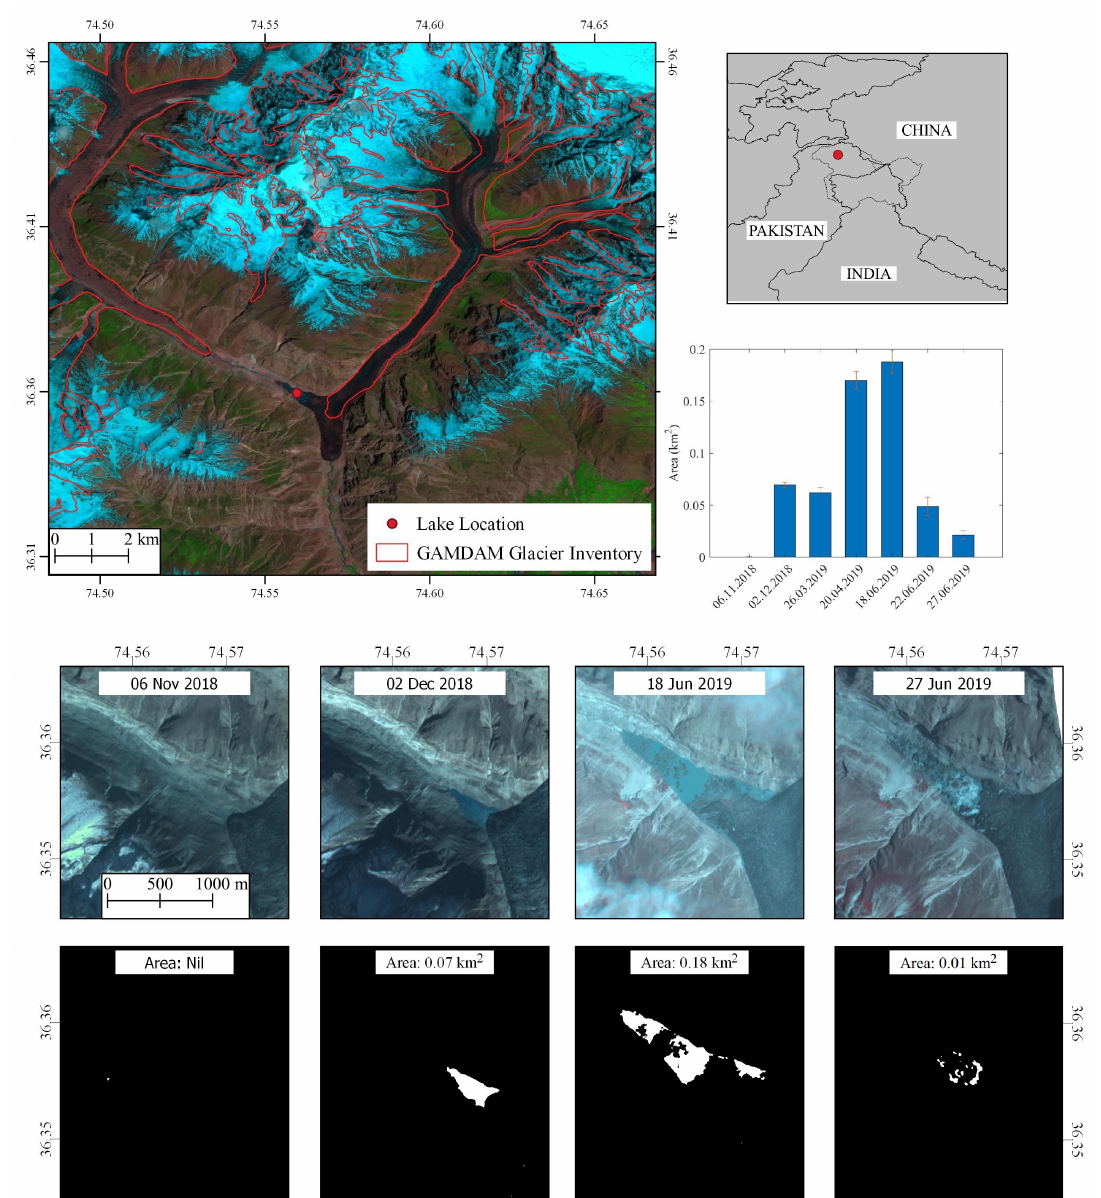
Figure 15. Top: The Shishper glacier shown on a Sentinel-2 FCC Bands: (11,8,4). The glacier boundaries from GAMDAM inventory [63] are shown for reference. The PlanetScope scenes from four different dates along with the predicted mask are shown. The histogram shows the change in the surface area of the